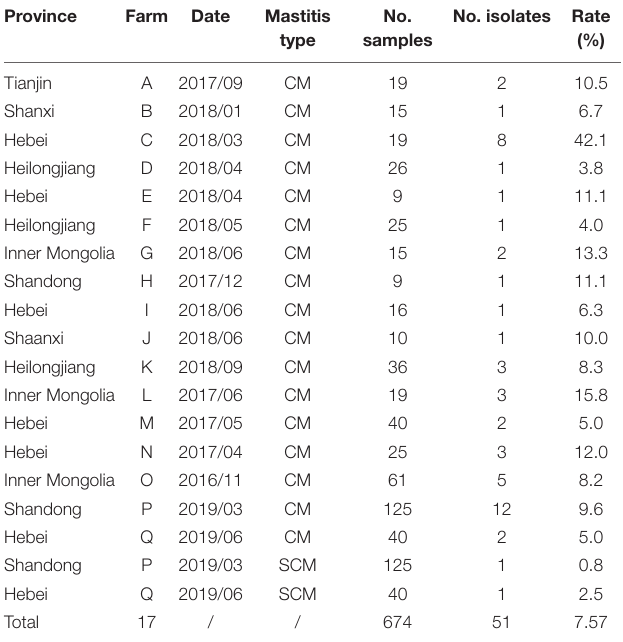
TABLE 1 | Streptococcus dysgalactiae subsp. dysgalactiae isolates ( n = 51) recovered from 509 bovine clinical mastitis (CM) and 165 subclinical mastitis (SCM) milk samples collected from 17 large dairy farms in 7 provinces of China.